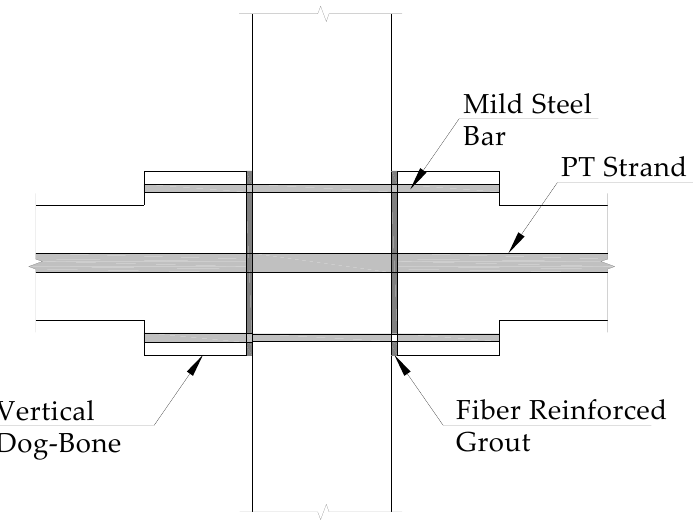
Figure 17. Precast column beam assembly with vertical dog bones.